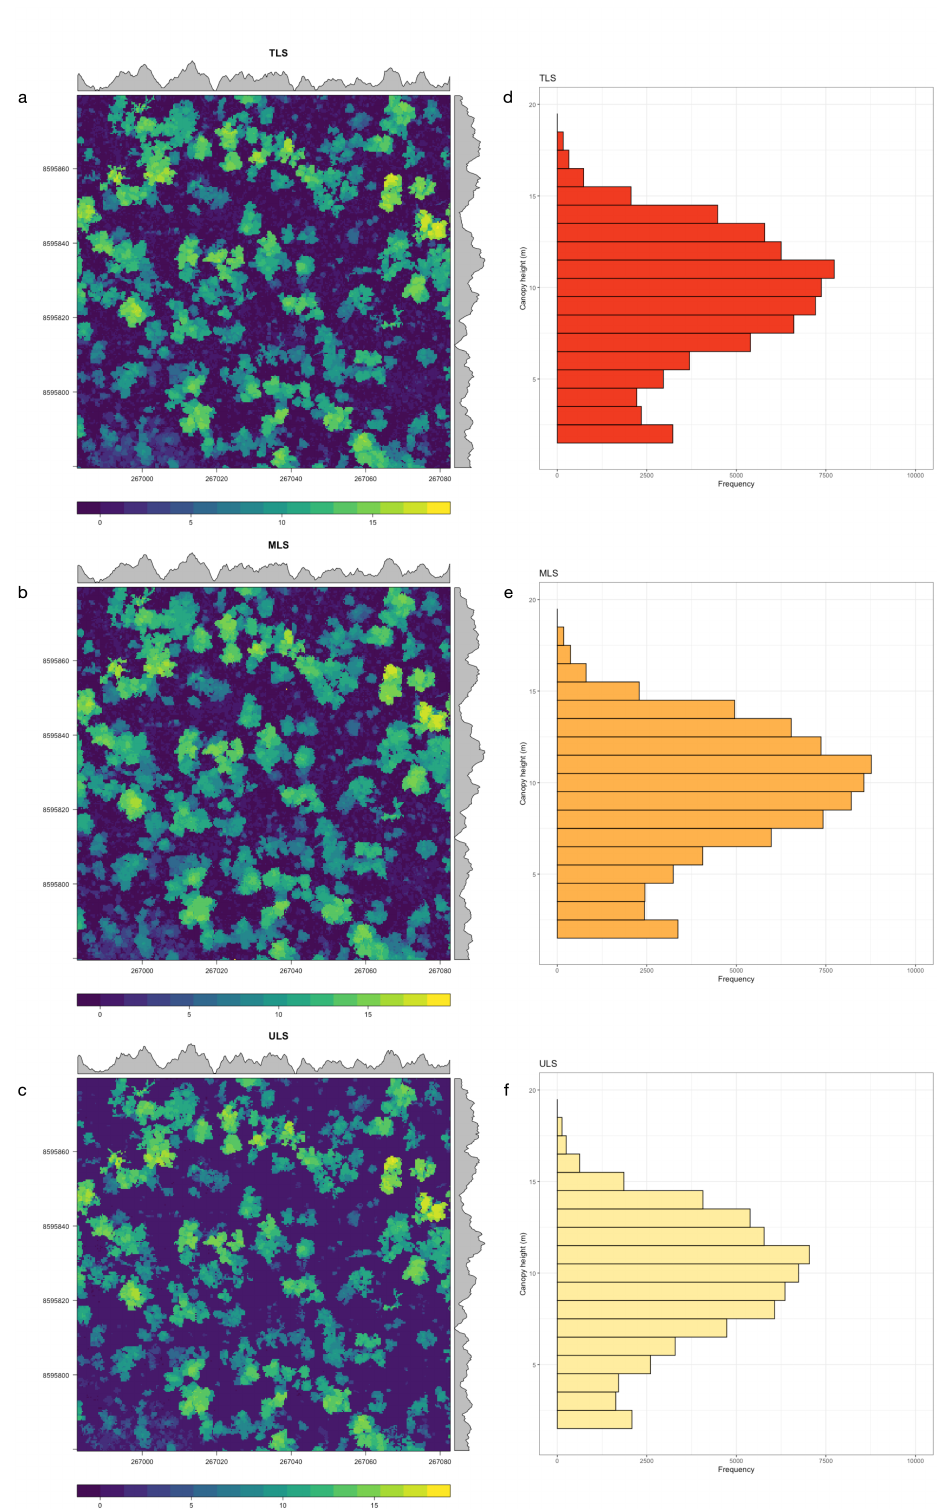
Figure 6. Canopy height models derived from the three co-incident LiDAR datasets, plotted at 0.25 m resolution ( a – c ) and their height class distributions ( d – f